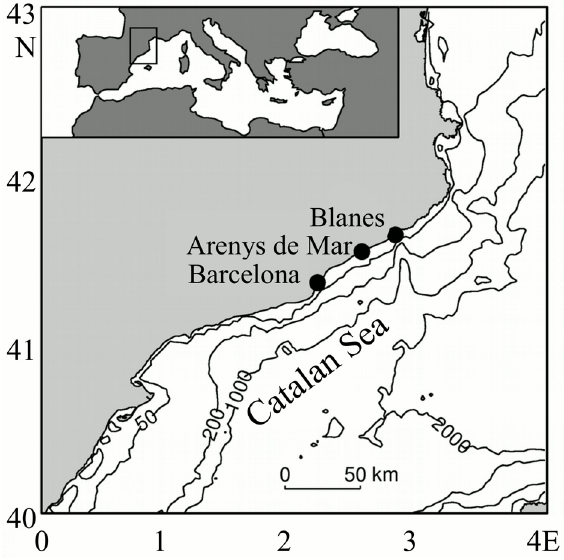
Fig 1. Map of the localization of the sampling sites at the Catalan coast. The inlet map shows the position of the Catalan Sea in the Mediterranean